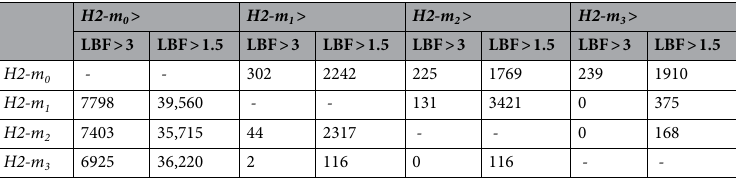
Table 3. Number of voxels showing model preference according to the specified LBF threshold for each of the performed model comparisons testing Hypothesis